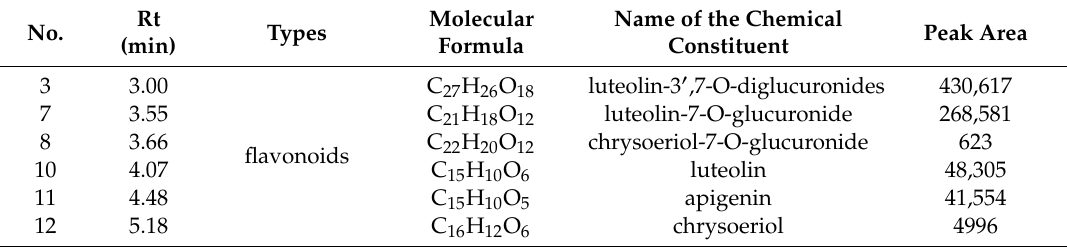
Table 2. Summary of the peak area of flavonoids from E. acoroides aqueous extracts.